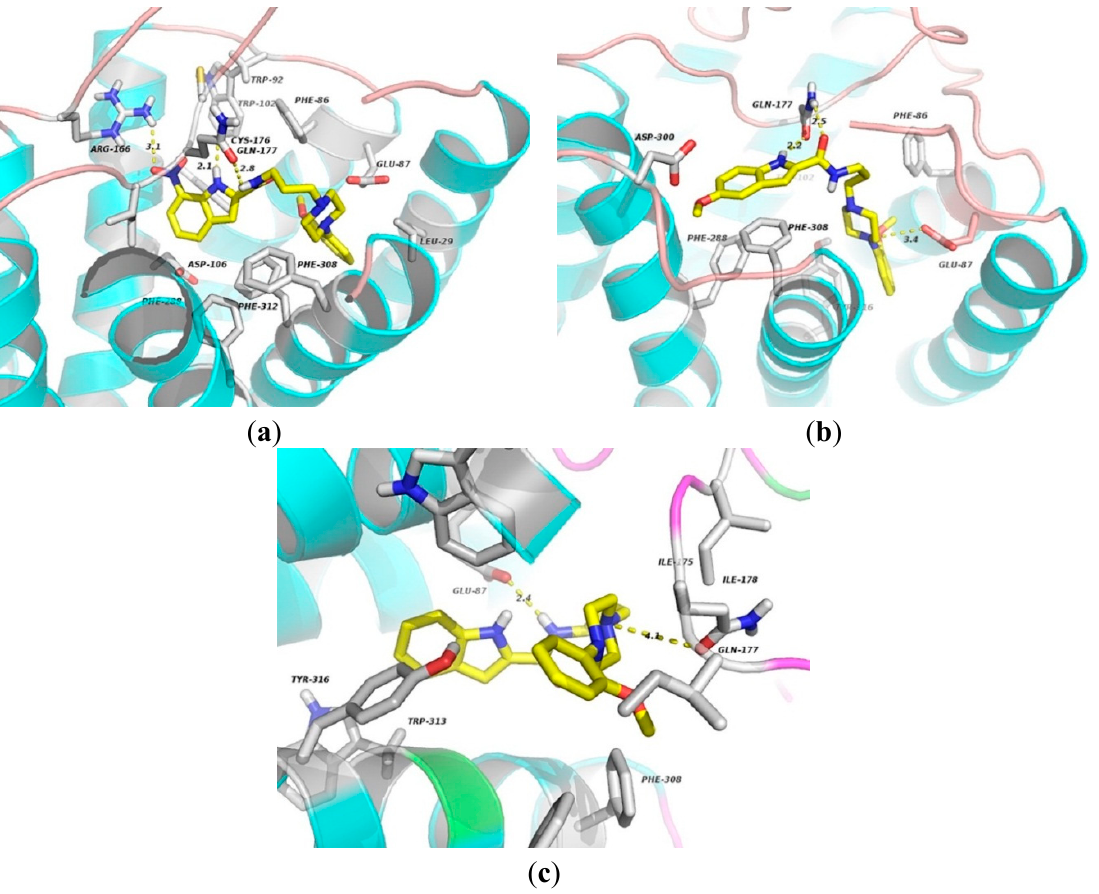
Figure 11. The docking complexes of ligands 1 ( a ); 2 ( b ); and 3 ( c ) with α 1A -AR. These compounds are shown in stick representation. The elements are coloured as follows: oxygen, red; nitrogen, blue; carbon, yellow. Dashed lines represent the hydrogen bonds or electrostatic interactions.